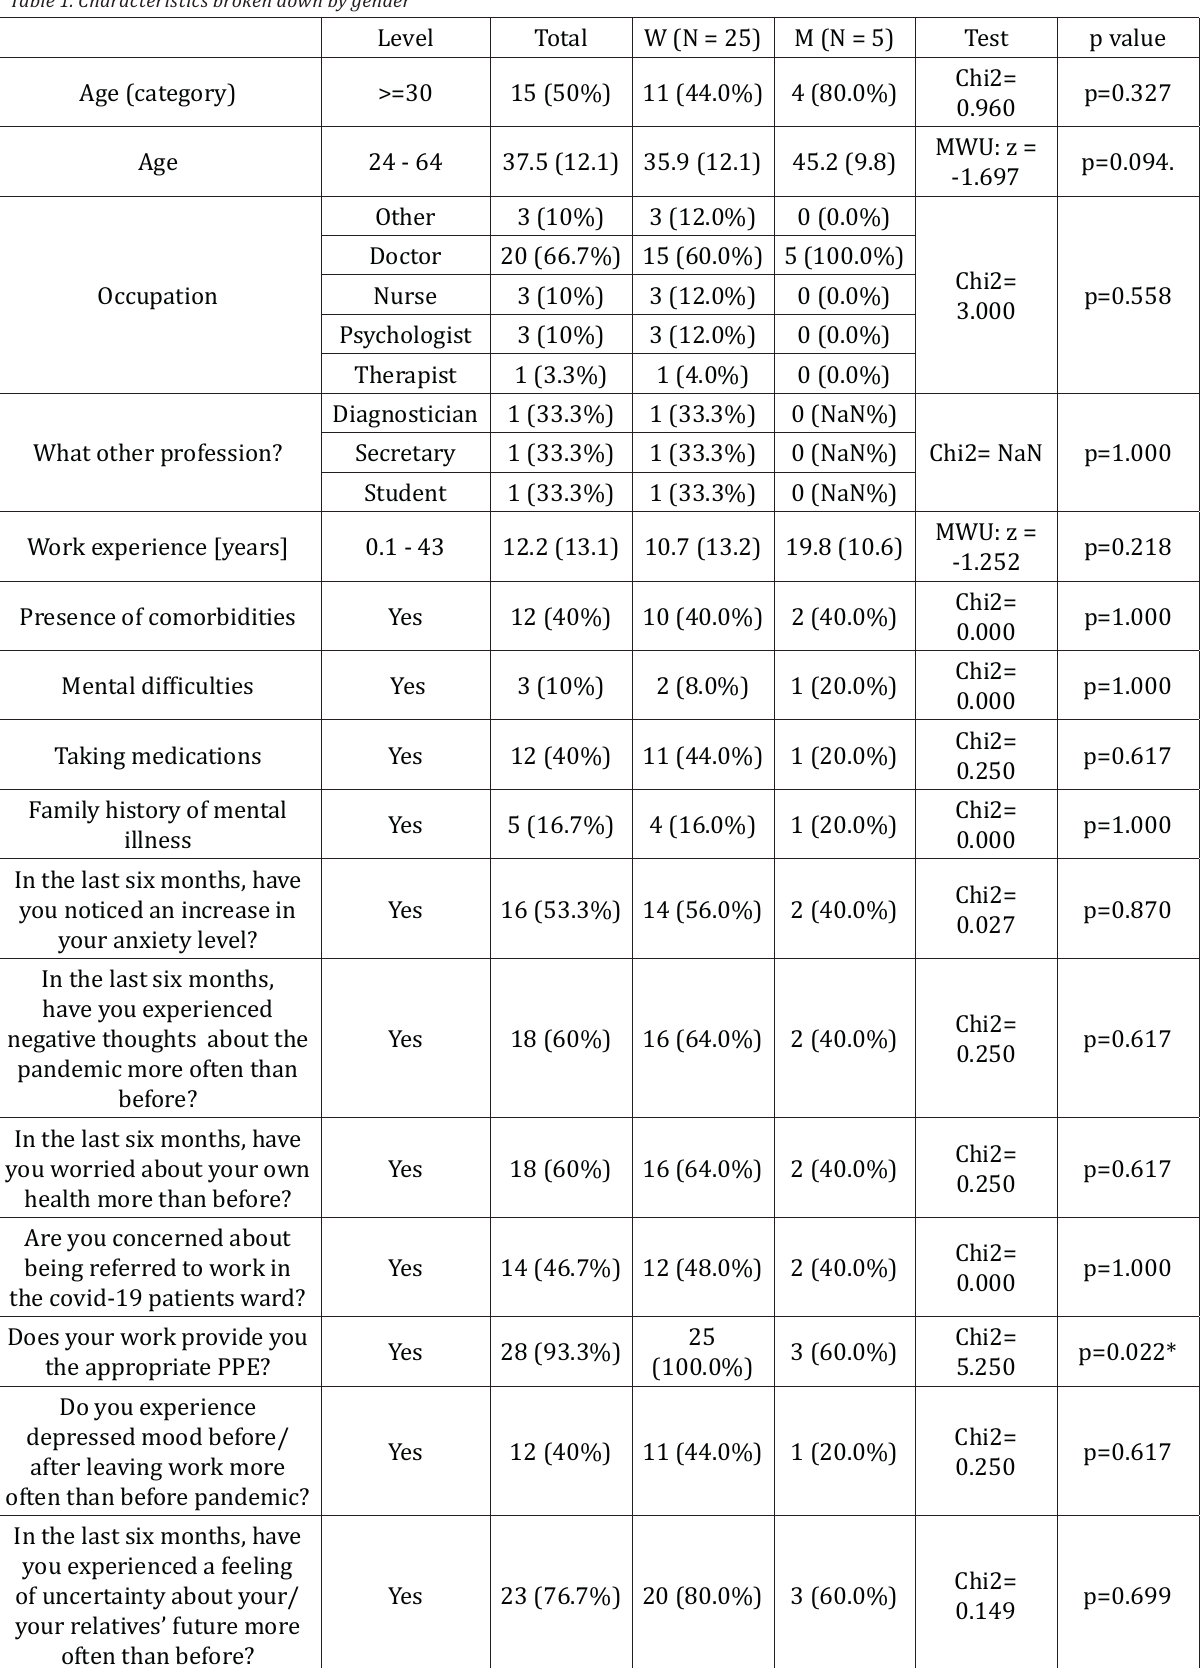
Table 1. Characteristics broken down by gender